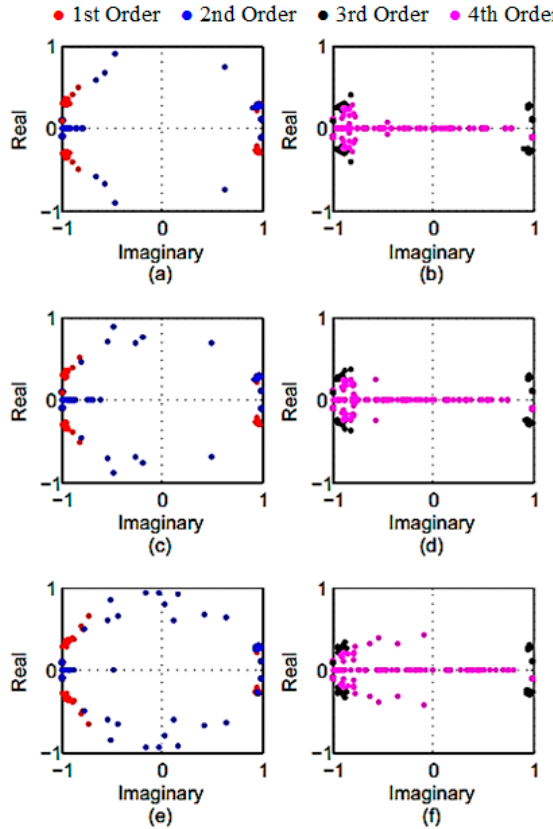
Figure 8. The estimated poles of the numerical model for: ( a ) 1st and 2nd and ( b ) 3rd and 4th orders in PC algorithm. ( c ) 1st and 2nd and ( d ) 3rd and 4th orders in UPC algorithm. ( e ) 1st and 2nd and ( f ) 3rd and 4th orders in CVA algorithm.